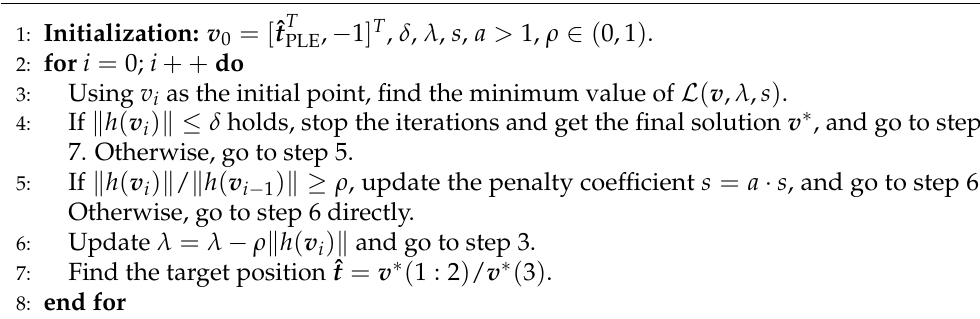
Algorithm 3 The GLM